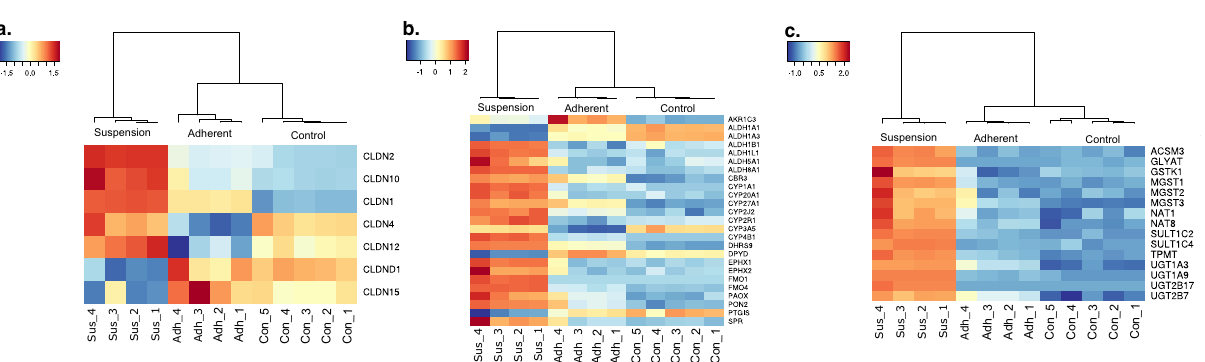
Figure 8. Heatmap of differentially regulated genes. The x-axis shows the samples and the y-axis represents the HGNC symbols. The coloring of the heatmap represents the standardized, normalized expression log2CPM values according to the legend at the top left side of each heatmap. ( a ) Heat map of tight junctions associated claudins. ( b ) Heatmap of differentially regulated drug metabolism genes for phase 1 modification. ( c ) Heatmap of differentially regulated drug metabolism genes for phase 2